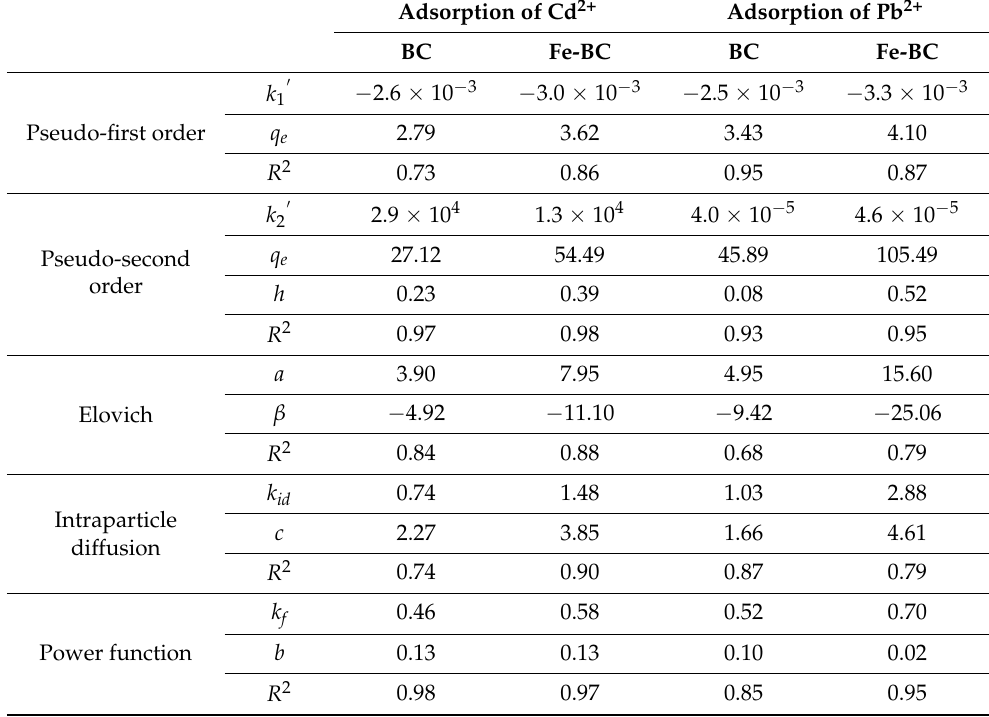
Table 3. Parameters obtained from kinetic models for cadmium (Cd 2+ ) and lead (Pb 2+ ) adsorption on date palm waste biochar (BC) and Fe-modified biochar (Fe-BC).